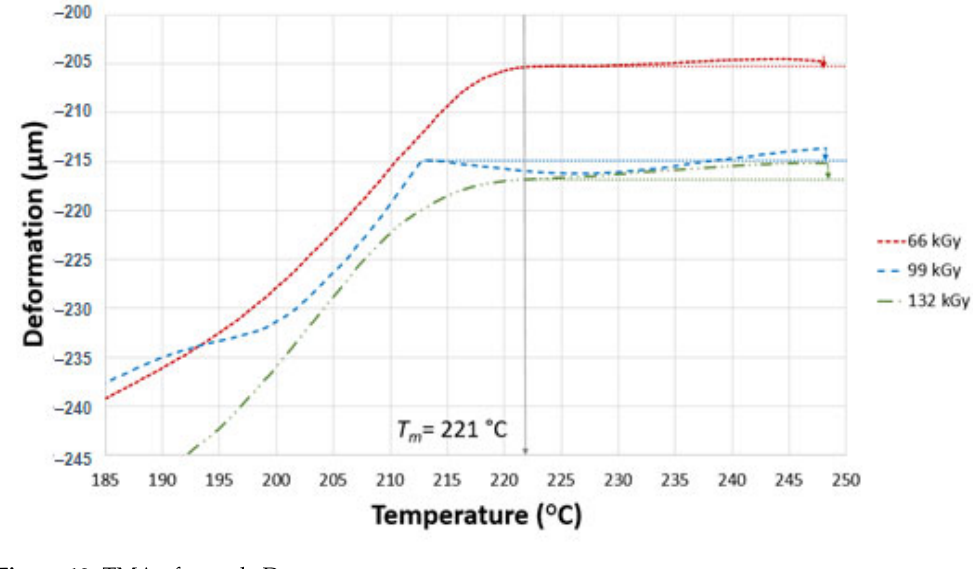
Figure 10. TMA of sample D.